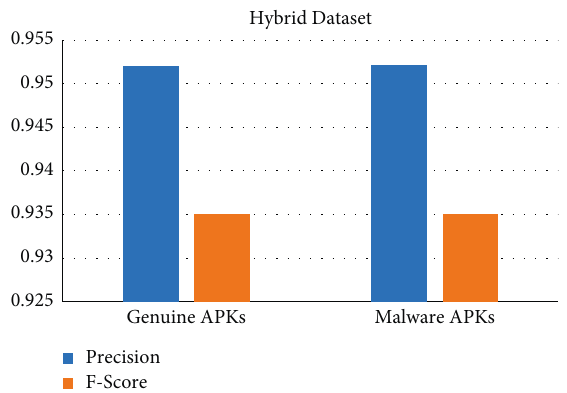
Figure 12: Precision and F-Scores for CNN